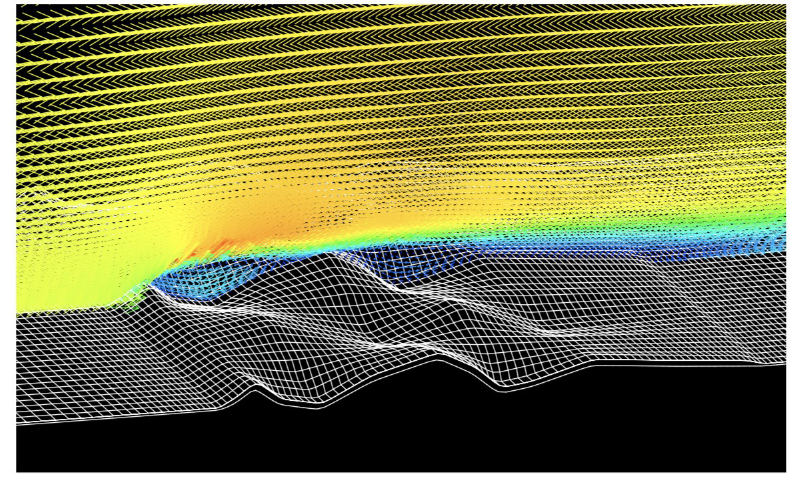
Figure 19. Instantaneous velocity field on the upper surface of the three dimensional corrugated wing at angle of attack of 2 ◦ and Re =